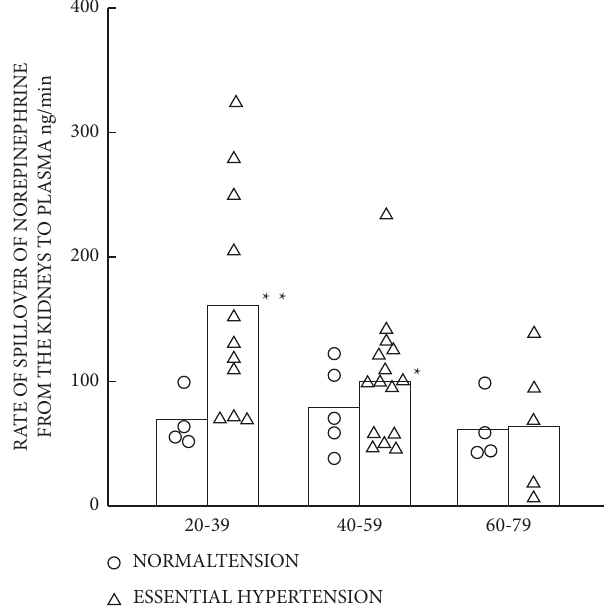
Figure 1: Influence of age (20–39, 40–59, and 60–79 years old) on renal norepinephrine spillover (ng/min) in normotensive and hypertensive patients. Note. ∗ p < 0 . 05; ∗∗ p < 0 . 01. Reproduced from reference